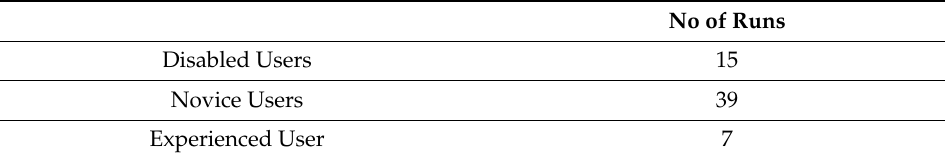
Table 1. Number of video